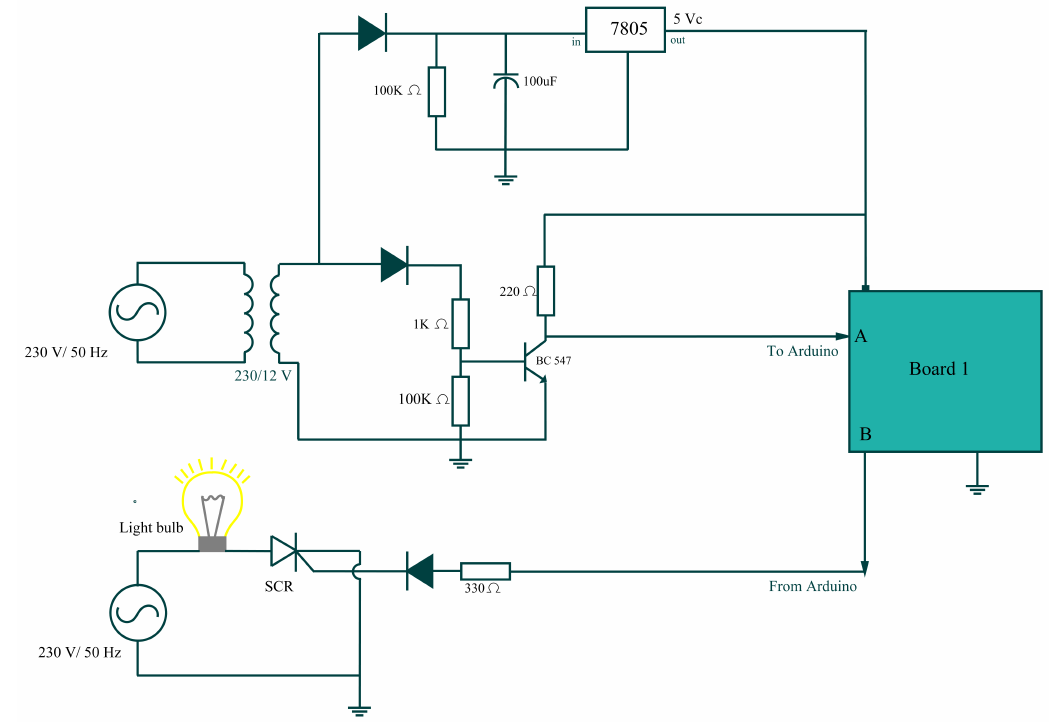
Figure A1. Electronic circuit to automatically control the bulb time-varying